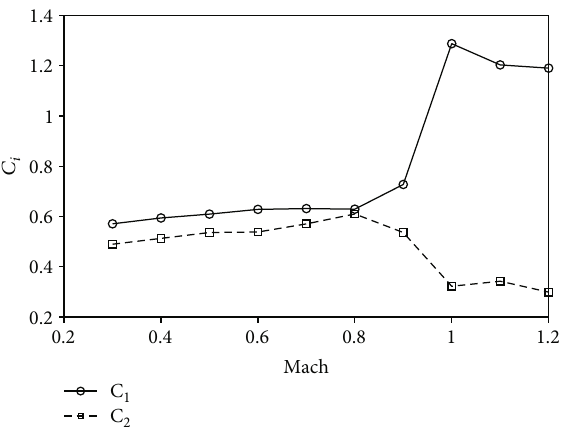
Figure 9: Control-coupling characteristics of the roll and yaw : roll control-coupling parameter; c channel ( c 1 coupling